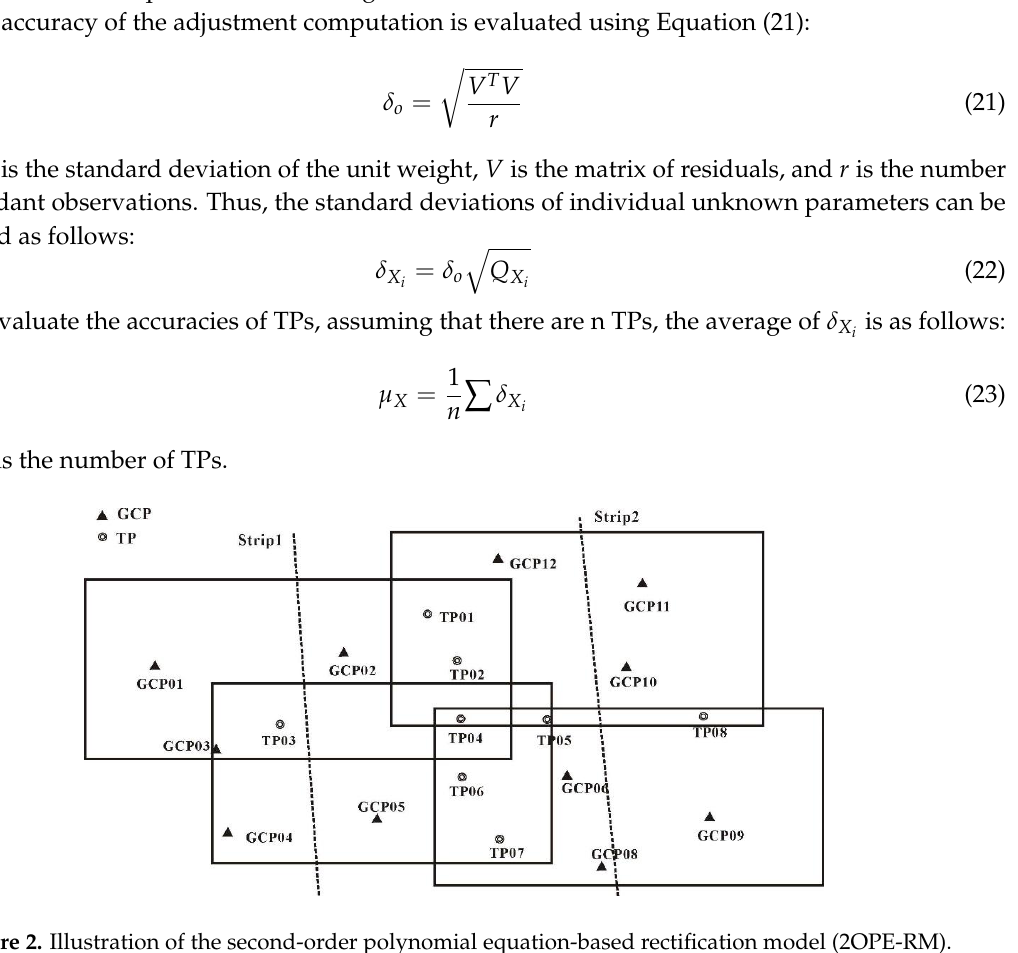
Figure 2. Illustration of the second-order polynomial equation-based rectification model